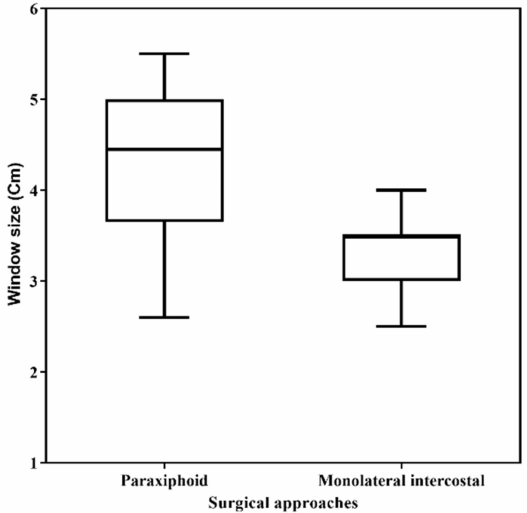
Figure 2. Comparison of the pericardial window size between two thoracoscopic pericardial tech- niques (paraxifoid technique vs. monolateral intercostal technique). Box-plot depicts window size’s minimum and maximum (whiskers) and medians (line across the box).